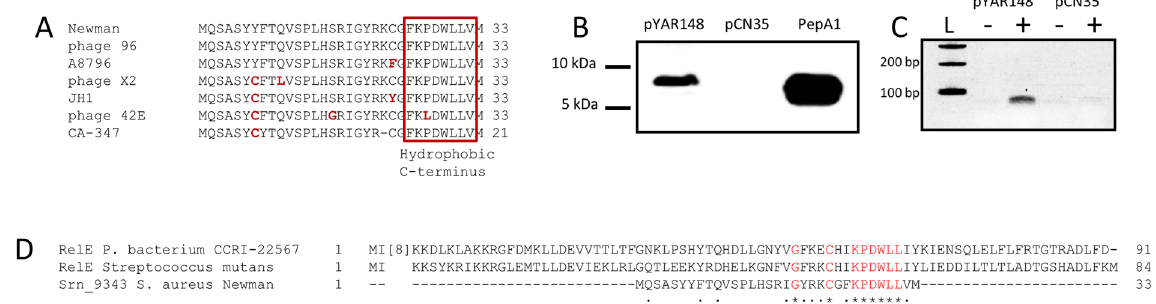
Figure 6. srn_9343 encodes a peptide expressed in Staphylococcus aureus that is secreted extracellularly. ( A ) Sequence alignment of the Newman peptide sequence with the S. aureus annotated peptides. ( B ) Western blot analysis of Srn_9343 flagged-peptide expression from pYAR148 (Table 6) under the pVeg promoter. This is compared to empty vector (pCN35) and to PepA1 from Sayed et al . 66 . ( C ) RT-PCR analysis of the expression of srn_9343 under the P veg promoter. ( D ) Sequence alignment of Srn_9343 with RelE toxins. The experimental data shown here are representative of three independent experiments. The dot and gel presented here were cropped for clarity purpose.